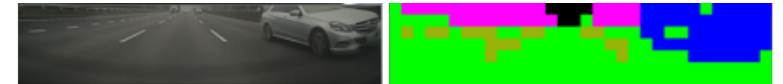
Figure 8. The pavement, lane marking, object approaching from the side, and object further away are shown in green, yellow, blue, and pink, respectively . The black part represents the uncertain region.